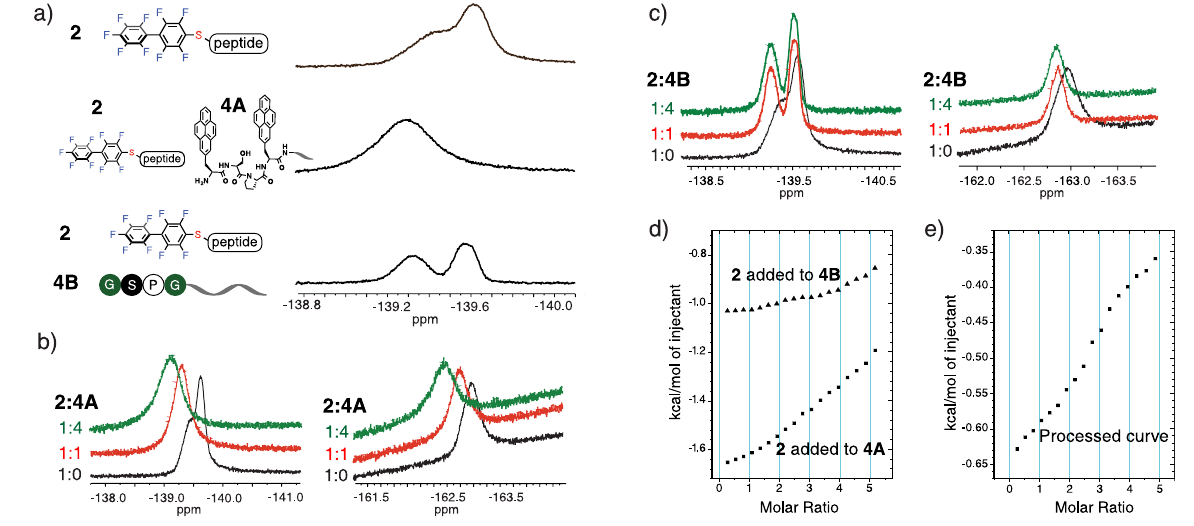
Figure 7. F NMR and ITC indicate interactions between peptide 4 A side chain and PFA probe 2 . ( a ) 19 F solution NMR spectra for probe 2 (top), 2 mixed with 1 equivalent 4 A (middle), and 2 mixed with 1 equivalent 4B (bottom). Conditions: 2 mM peptide or probe, 20 mM phosphate, pH 7, 10% D 2 O, 90% H 2 O. ( b , c ) 19 F solution NMR spectra for the titration experiment in which the equivalent of peptide 4 A ( b ) or 4B ( c ) relative to 2 was increased. Concentration of 2 was fixed at 2 mM. ( d ) Isothermal titration calorimetry binding curves for 2 interacting with 4 A and 4B . 5 mM probe 2 was added into 0.2 mM 4 A or 4B in the titration experiment. e ) Processed ITC binding curve where the interaction between 2 and 4B was deducted as background from the interaction between 2 and 4 A